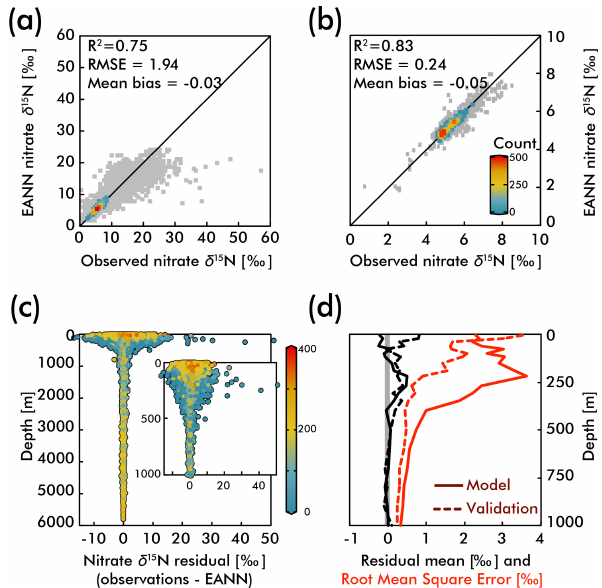
Figure 3. The observed versus EANN-predicted nitrate δ 15 N are shown for all data at all depths in (a) and for > 1000m in (b) . The colors indicate the number of comparisons on the World Ocean At- las grid (legend in b ; gray = 1 observation). The anomalously high observed nitrate δ 15 N values ( > 30‰) in (a) are exclusively from the eastern tropical South Pacific waters (Bourbonnais et al., 2015; Casciotti et al., 2013; Rafter et al., 2012; Ryabenko et al., 2012). The difference (or residual) between the observations and EANN nitrate δ 15 N is shown for all depths and the upper 1000m in (c) with colors representing the dissolved oxygen content. Note the largest offsets between 100 and 500m in (c) are associated with lowest oxygen content. Similarly, the mean residual (black) and root mean square error (RMSE; red) with depth (d) are highest in the upper 500m. Dashed lines in (d) demonstrate the same statistics, but for the external validation dataset (blue in Fig.